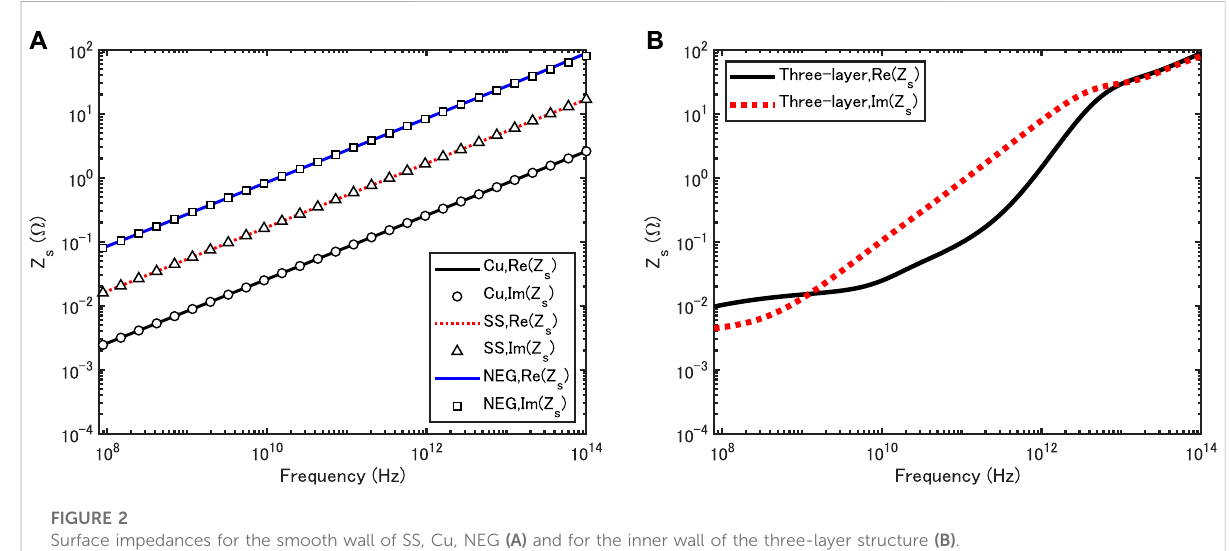
FIGURE 2 Surface impedances for the smooth wall of SS, Cu, NEG (A) and for the inner wall of the three-layer structure (B)